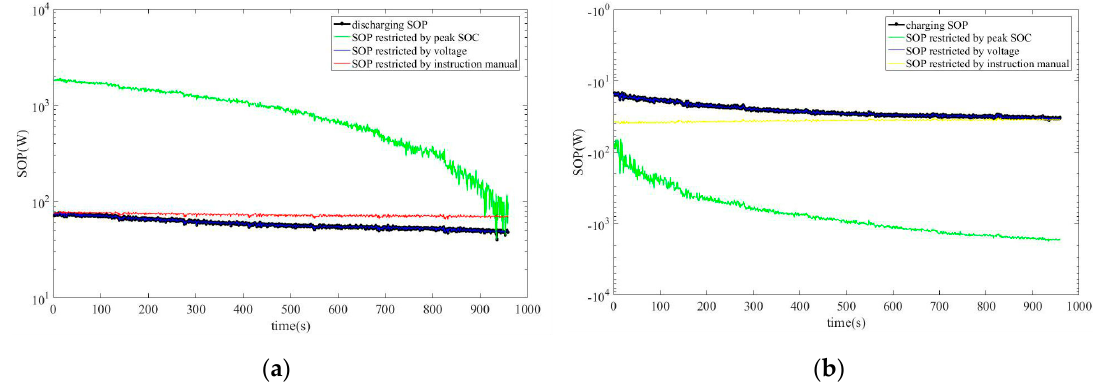
Figure 11. ( a ) SOP and ( b ) charging SOP with different limitations on the FUDS.